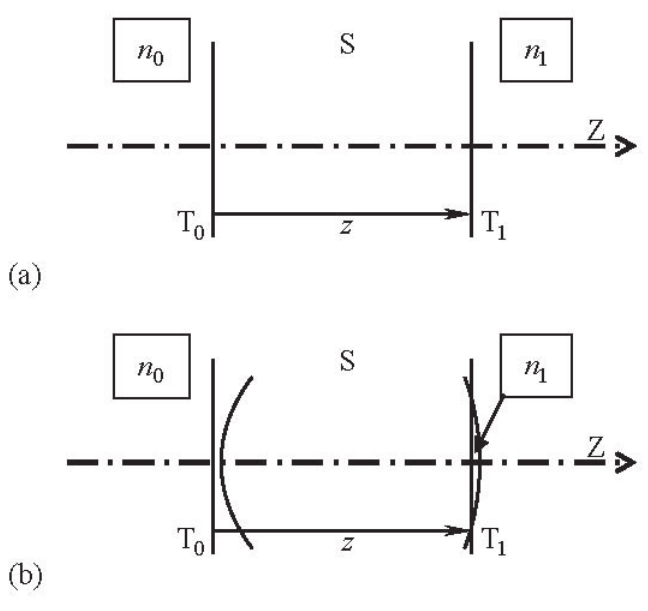
Figure 1 (a) An arbitrary dioptric system S with optical axis Z. None of the optical elements of S is shown. Z defines the positive sense through S. T is the entrance plane, T the 0 1 exit plane and z is the length of S. The indices of refraction immediately upstream of T and immediately downstream of T 0 1 are n and n respectively. (b) S is the visual system of an eye. 0 1 T lies immediately upstream of the first surface of the tear film 0 (shown as a curved surface) on the cornea and T immediately 1 upstream of the retina (also